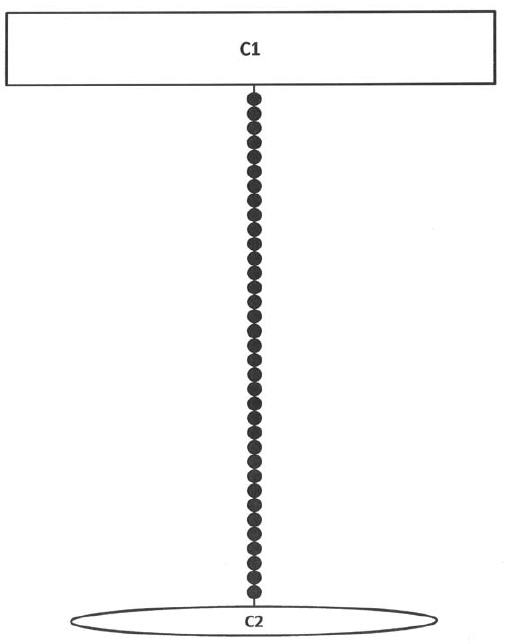
Figure 1. Statistical parsimony networks for COI haplotypes of Bactrocera caudata . Lines represent parsimonous connections be- tween haplotypes and the small circles indicate missing haplotype. The size of square or oval corresponds to the haplotype frequency.